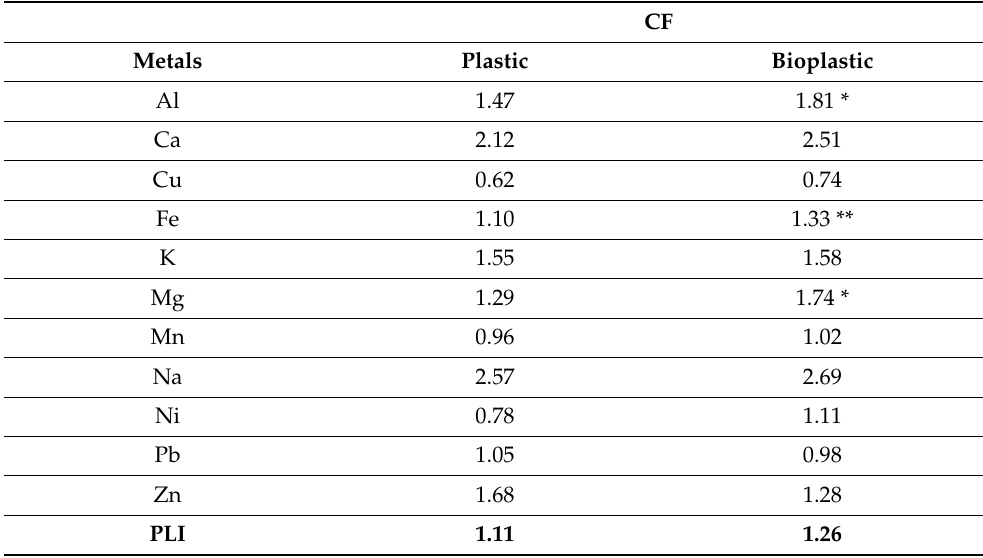
Table 2. Mean values of the Contamination Factor (CF) and, in bold, of the Pollution Load Index (PLI) for the investigated soil covered by plastic and bioplastic. Asterisks indicate significant differences between plastic and bioplastic ( t -test; p <